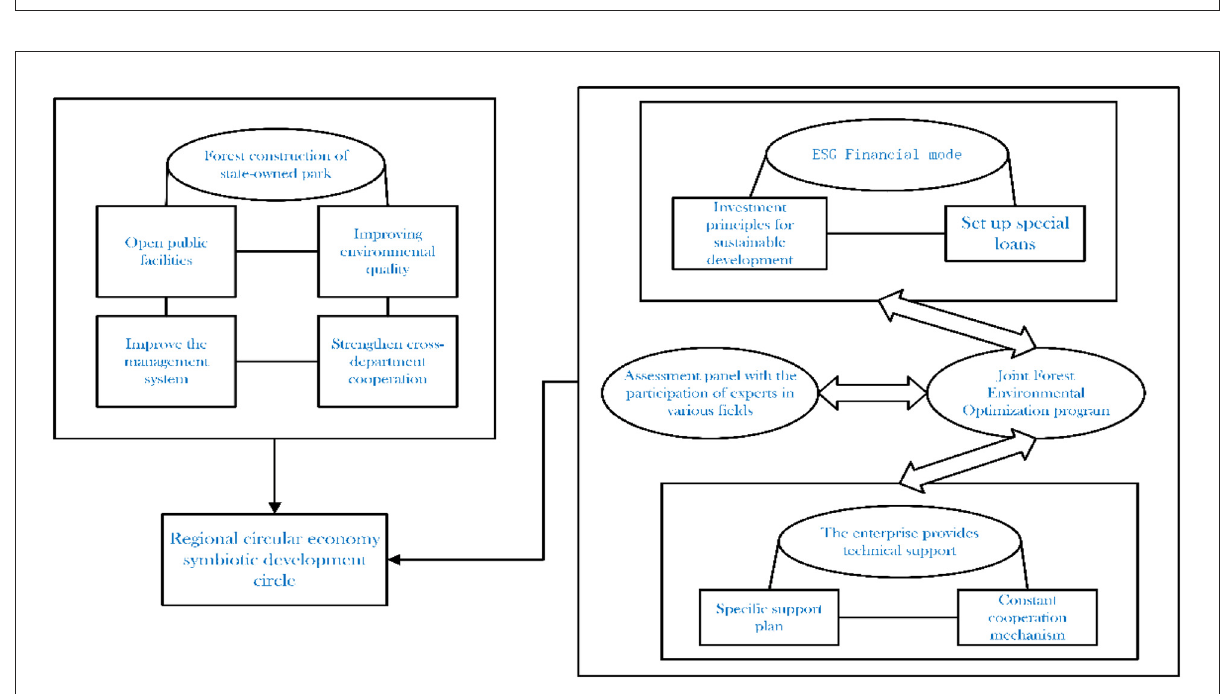
FIGURE11 Forest services industry development in a policy collaborative environment.